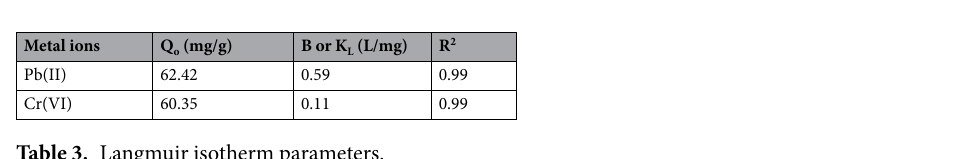
Table 3. Langmuir isotherm